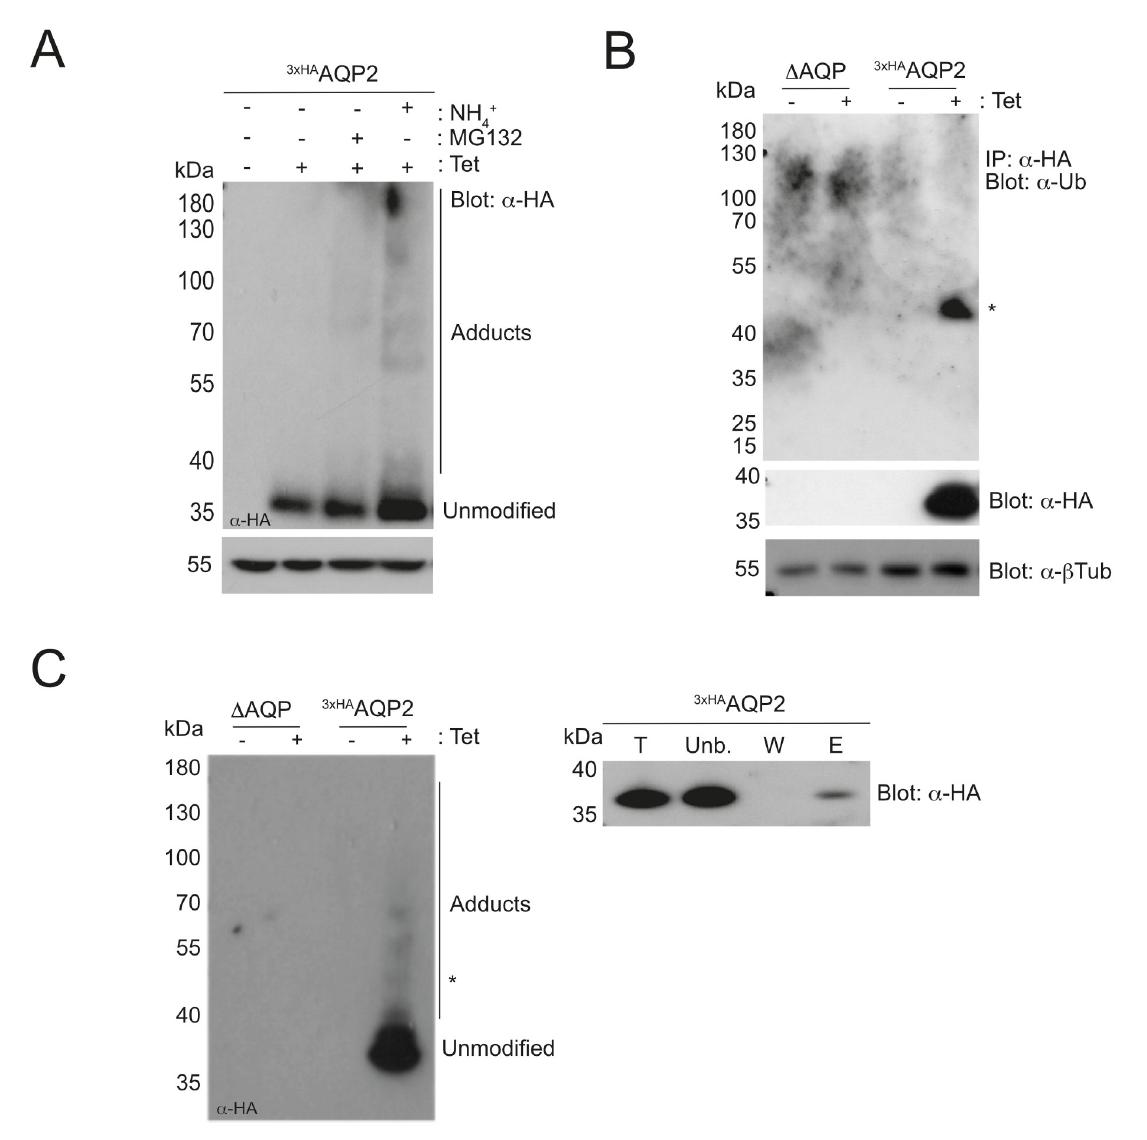
Fig 3. TbAQP2 is ubiquitylated in T . brucei . A) Cells expressing 3xHA AQP2 were treated with either NH 4+ Cl (10 mM) or MG132 (25 μ M) for 1h prior to harvesting. Cell lysates were resolved in a 4–12% acrylamide gel and detected with anti-HA antibody by western blotting. The intensity of anti- β tubulin was used as loading control. B) Immunoprecipitation of Δ aqp or 3xHA AQP2 cell lysates with anti-HA beads followed by anti-ubiquitin detection by western blotting. An anti-HA blot was also included to confirm protein expression upon induction with tetracycline. Anti- β tubulin was used as loading control. ‘ � ’ indicates the predicted migration poition of a monoubiquitylated 3xHA AQP2. C) As in (B), but immunoprecipitation conducted using ubiquitin capture matrix and analysed by western blotting (left panel). The total (“T”), unbound (“Unb.”), wash (“W”), and elution (“E”) fractions were resolved by SDS-PAGE electrophoresis and analysed with anti-HA immunoblotting (right panel). ‘ � ’ is as in panel